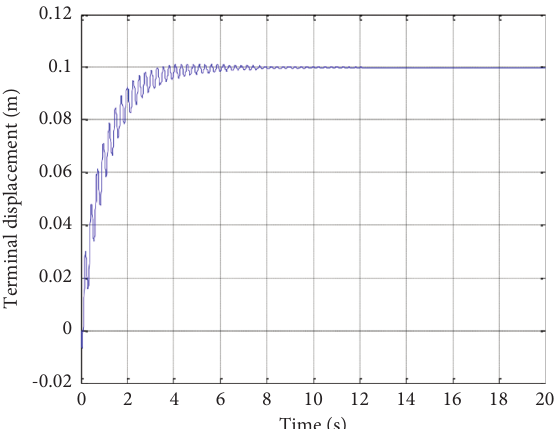
Figure 13: Tip displacement p